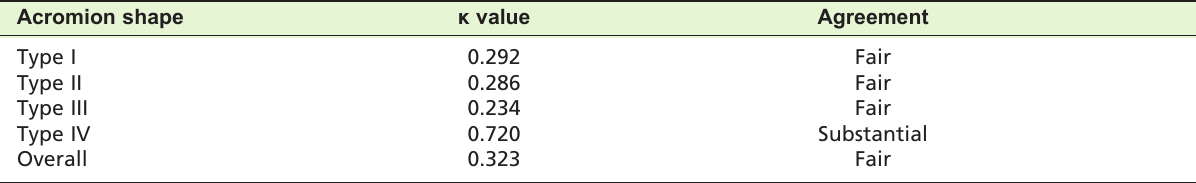
Table II: Average κ values and agreement for each acromion types for all nine observers